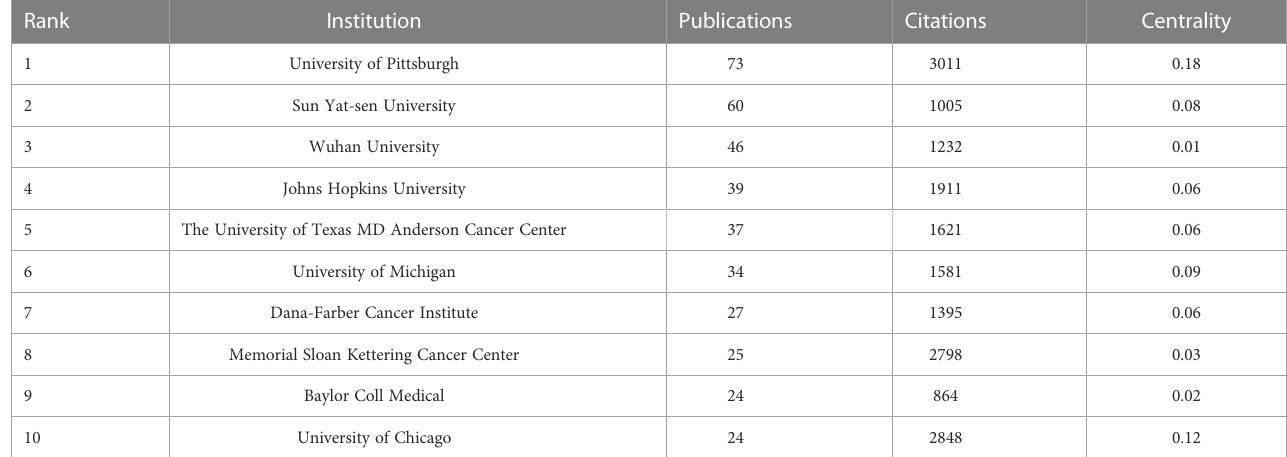
TABLE 2 Top 10 institutions publishing research articles on immunotherapy for